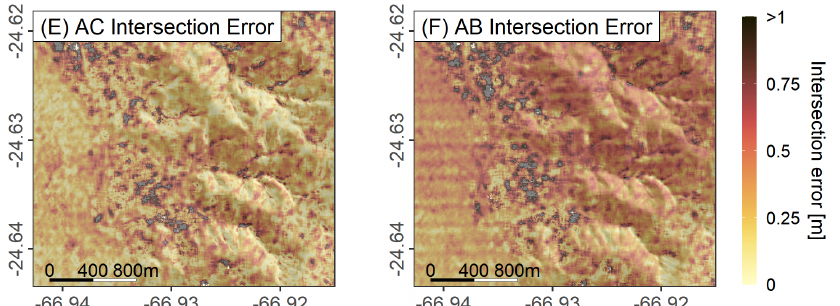
Figure 4. ( A ) Map–projected SPOT6 PAN B–scene. The white color to the west is the edge of the salar (white is from salt patches), and there is an alluvial fan in the center of the view, which emanates from the steep mountains to the east; ( B ) the PAN variance calculated on ( A ) in a 5 × 5 window, and logarithmically scaled; ( C ) resulting SPOT6 DEM from pairwise correlation of the AC scenes and for the AB neighboring scenes ( D ); ( E ) Intersection error output by the ASP for the AC DEM and for the AB DEM ( F ); See Figure 2A for location in study